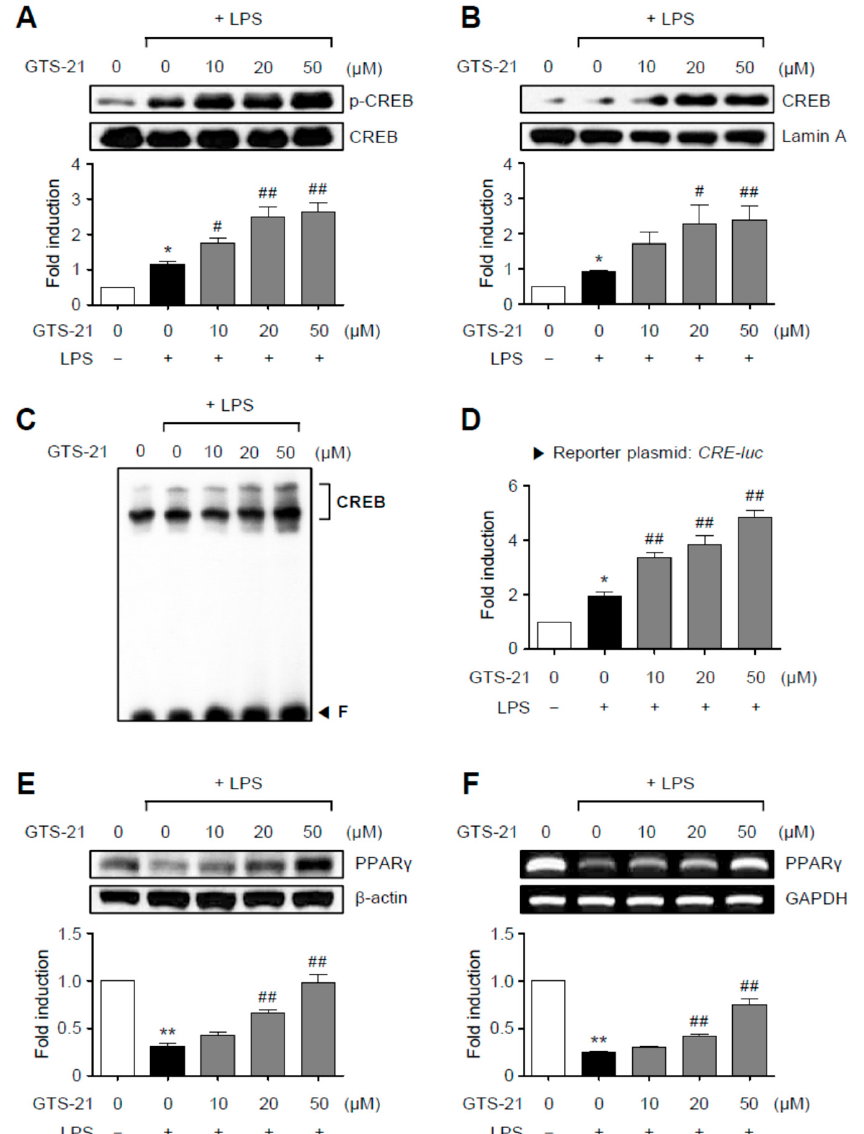
Figure 4. GTS-21 enhanced CREB and PPAR γ signaling in LPS-stimulated BV2 cells. ( A ) BV2 cells were pretreated for 1 h with GTS-21 at the indicated concentrations before being stimulated with LPS for 30 min ( n = 3). The levels of phospho- and total CREB were determined using western blot analysis on cell lysates. ( B ) CREB nuclear translocation was detected using a western blot ( n = 4). Quantification data are shown at bottom. ( C ) Nuclear extracts from BV2 cells treated with GTS-21 in the presence of LPS for 1 h were used to perform EMSA for CREB. ( D ) CRE-luc reporter gene activity after transient transfection ( n = 3). ( E , F ) BV2 cells were treated with GTS-21 for 1 h before being incubated with LPS for 6 h. To determine the effects of GTS-21 on the protein and mRNA expressions of PPAR γ , western blot analysis ( E ) and RT-PCR ( F ) were performed ( n = 3–4 per group). The upper panel shows representative blots/gels, while the bottom panel shows quantitative data. The data are presented as the mean ± SEM. * p < 0.05, vs. control group; ** p < 0.01, vs. control group; # p < 0.05 vs. LPS-treated group; ## p < 0.01 vs. LPS-treated